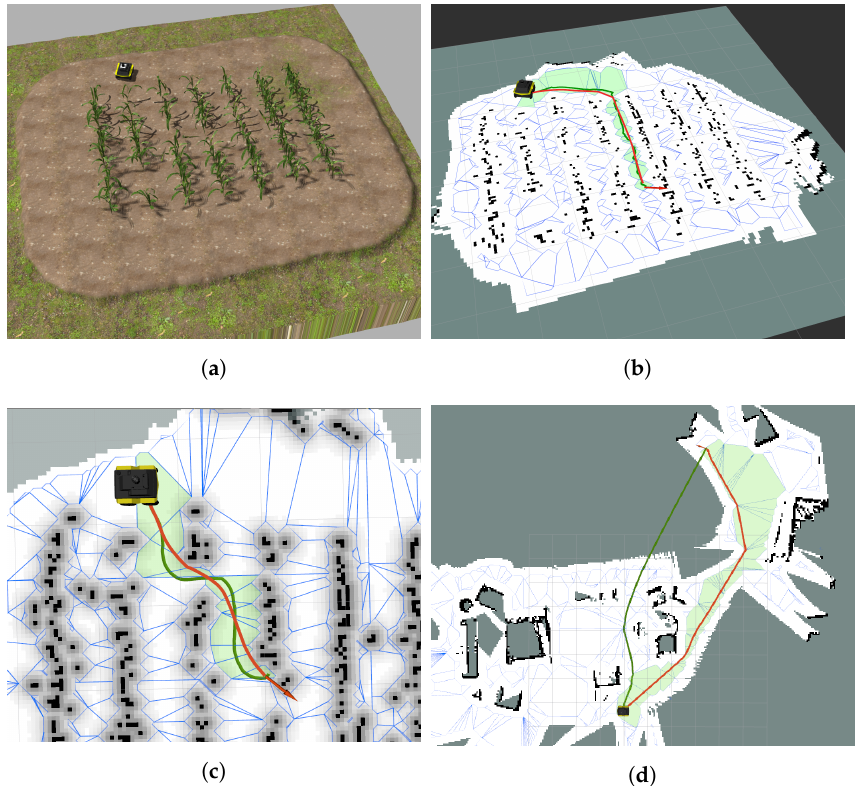
Figure 10. Comparisons of different path planning methods in occupancy grid maps: Navigation with Polytopes toolbox (red lines) versus the standard Navfn of ROS (green lines). ( a ) Agriculture field in the Gazebo simulation; ( b ) results in the field map: test case 1; ( c ) results in the field map: test case 2; ( d ) results in an earthquake-affected